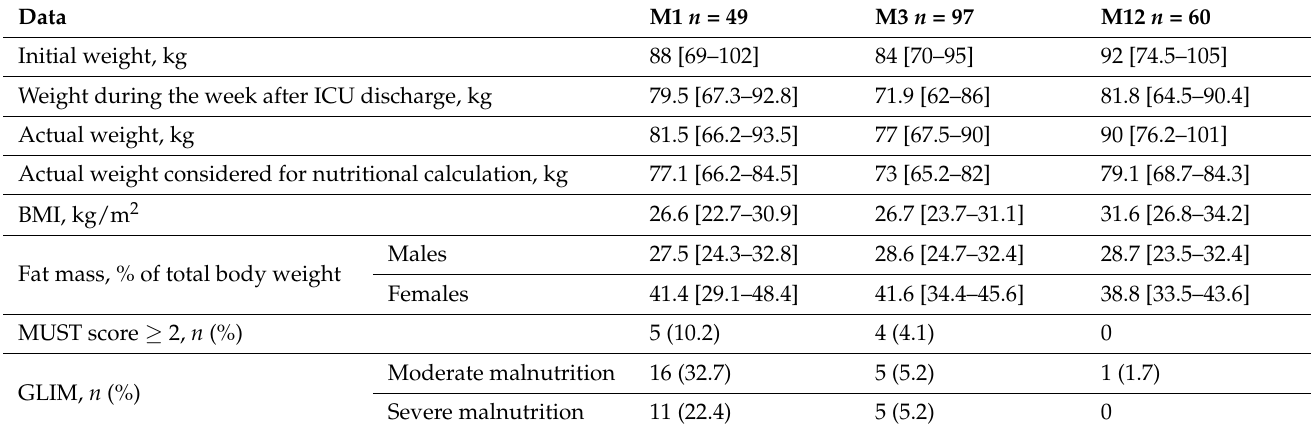
Table 2. Nutritional data, body composition and functional outcomes at the three